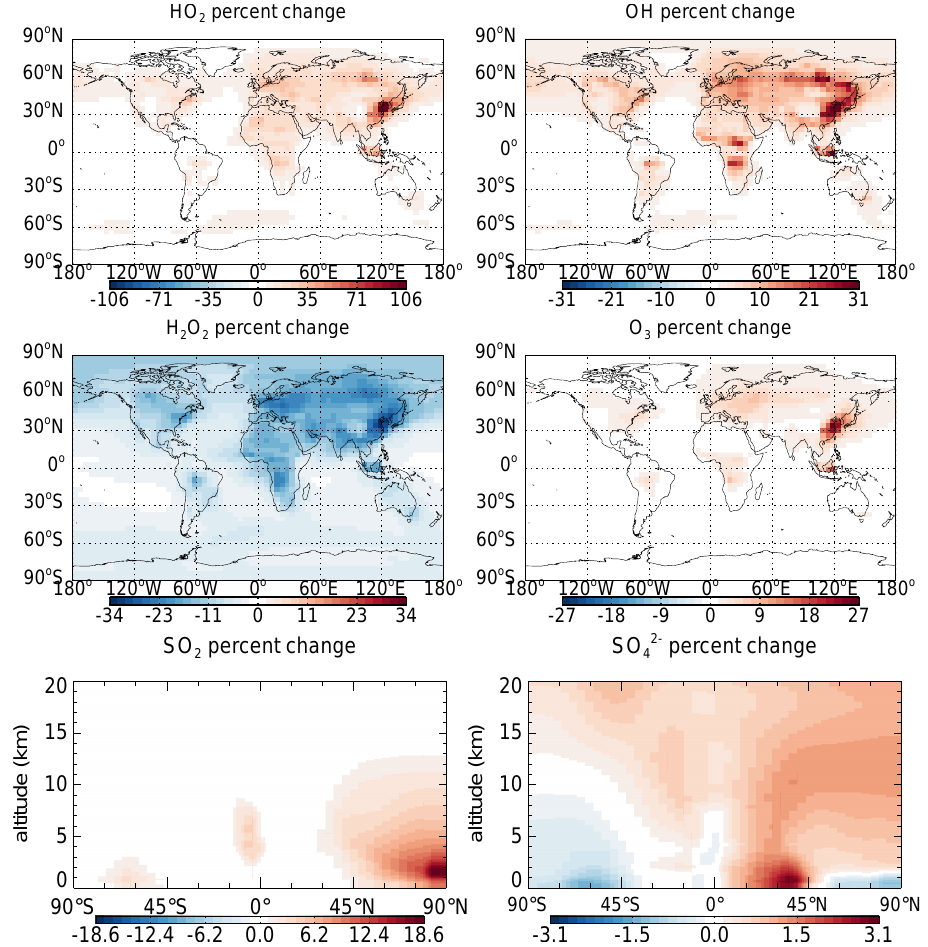
Fig. 5. Impact on annual mean concentrations of oxidants and sulfur species when moving from a γ HO (Jacob, 2000) to the scheme presented in Table 1.